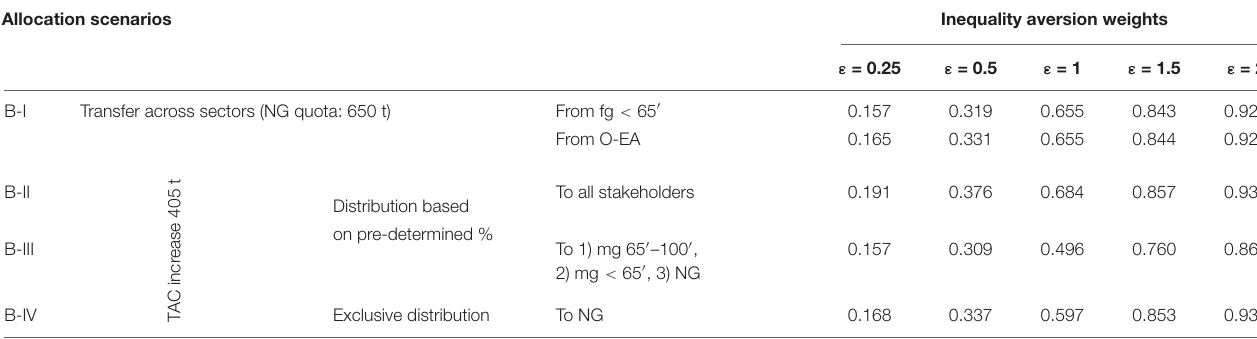
TABLE 2 | Atkinson index (A t ) estimates for different allocation scenarios under varying aversion to inequality. Allocation